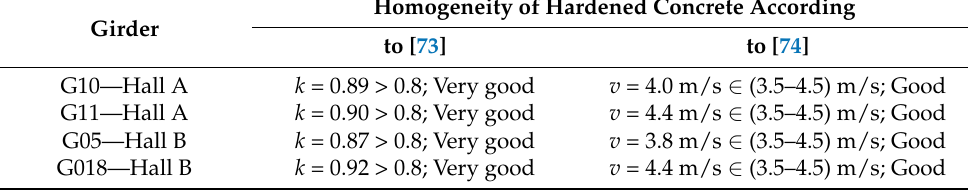
Table 5. The homogeneity of hardened concrete from ultrasonic test (girders G10 & G11—Hall A, girders G05 & G018—Hall